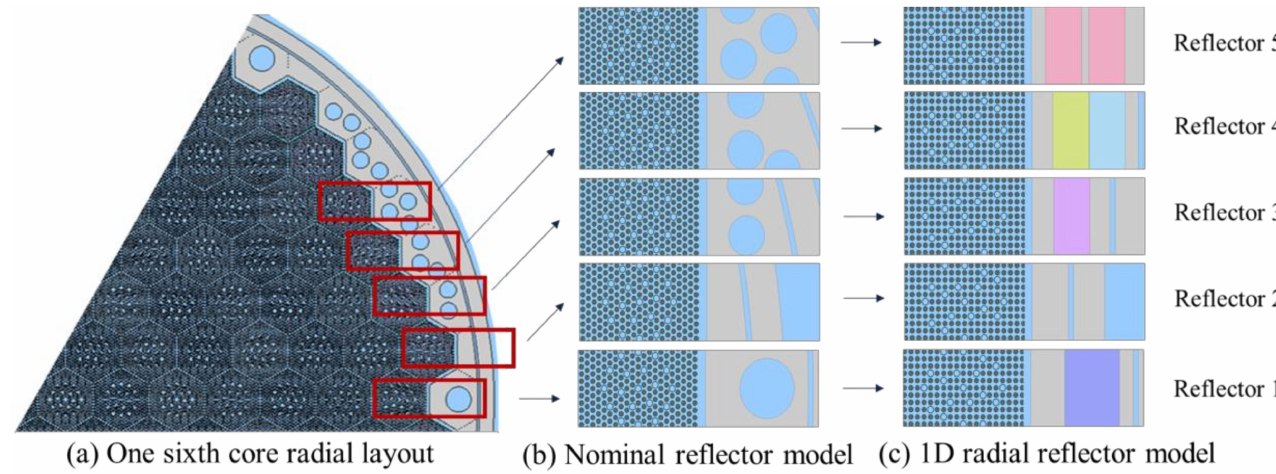
Figure 5. Radial layout of 1D radial reflector model.